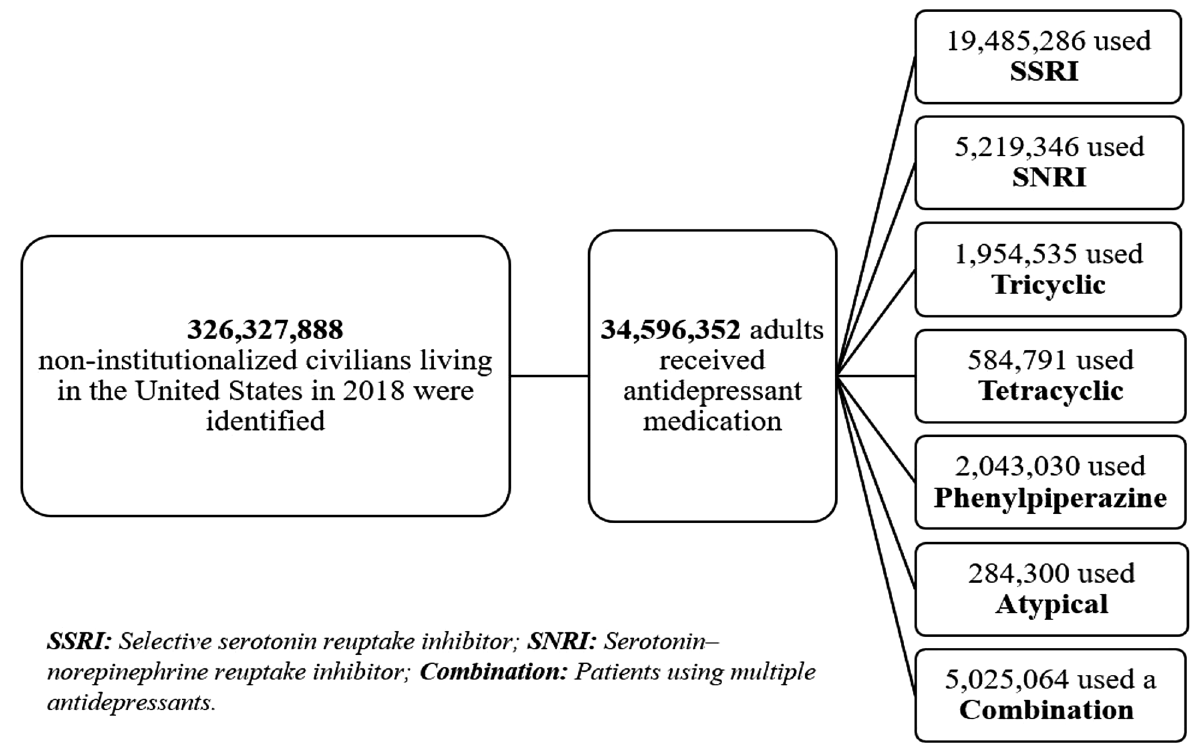
Figure 1. Flowchart of patients using antidepressant therapy in the